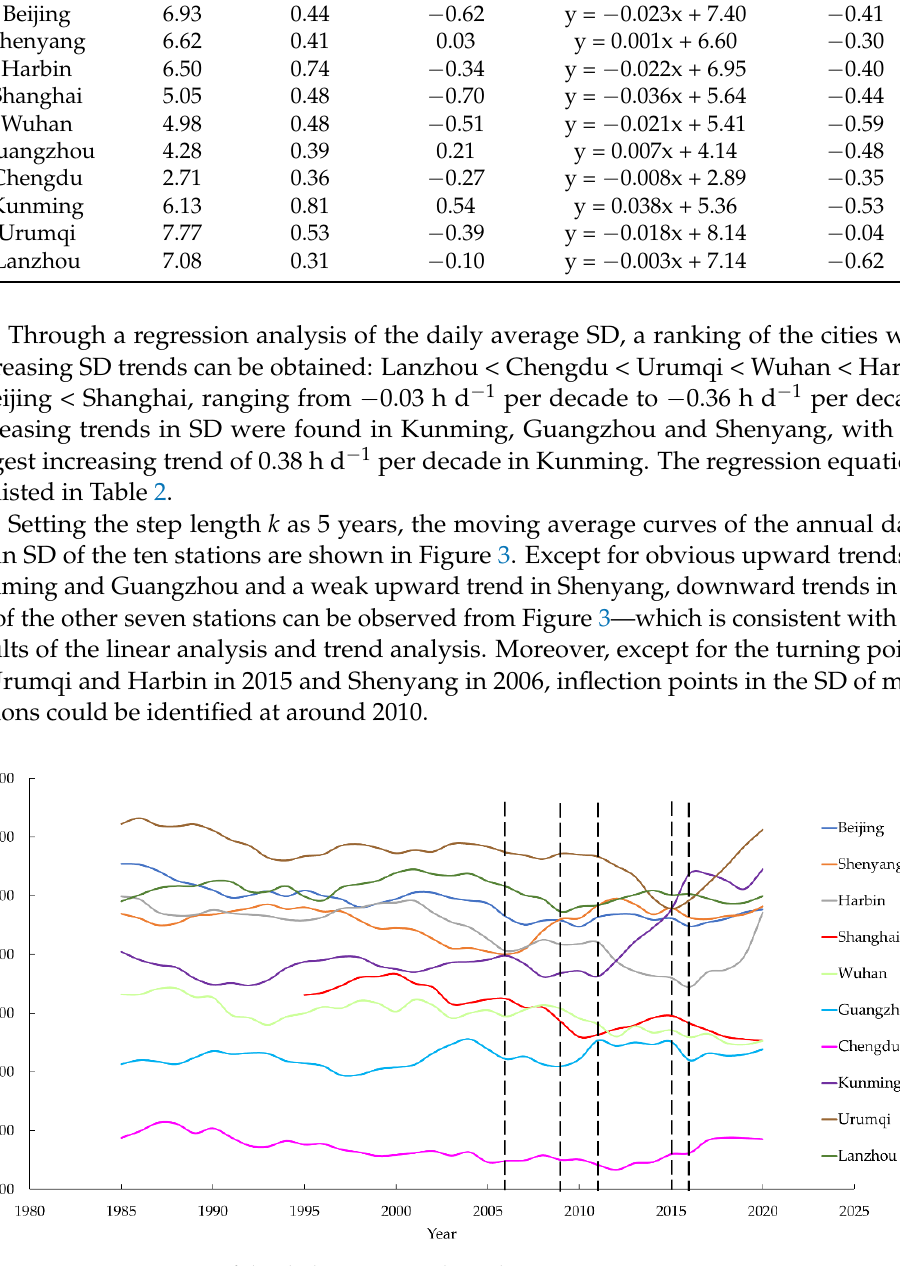
Figure 3. Moving average of the daily mean sunshine duration per year.